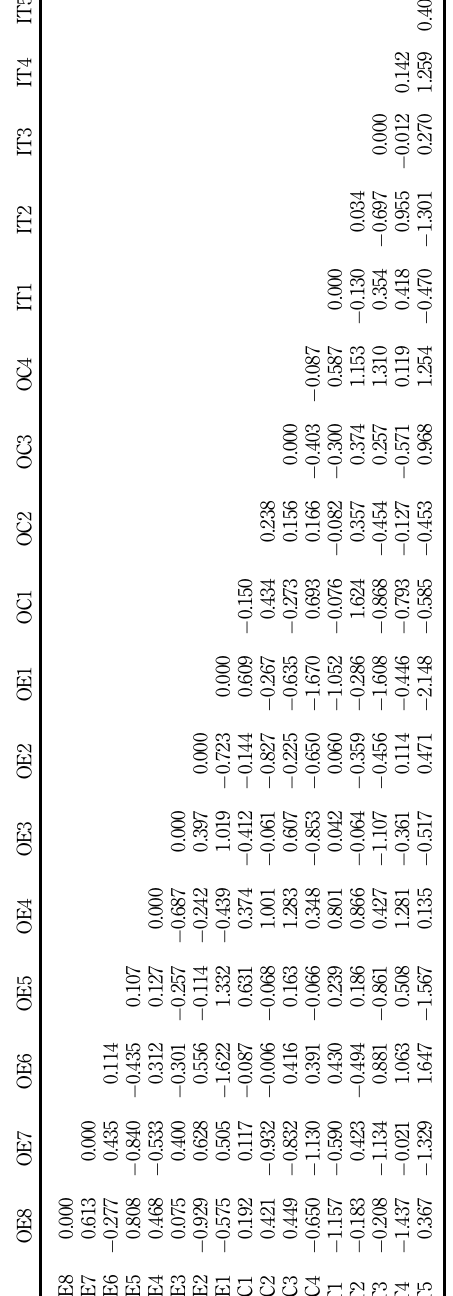
Table A2. Standardized